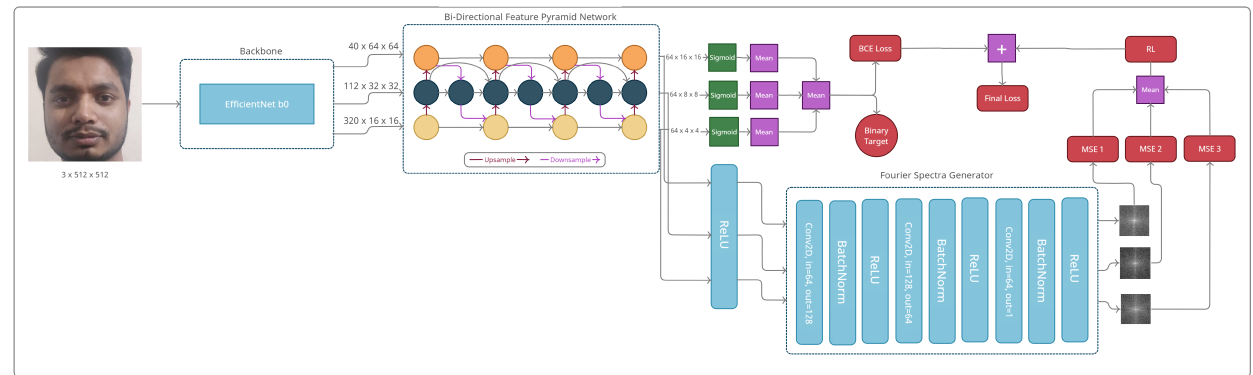
Figure 6. Extension of our baseline BiFPN architecture with a convolutional generator and reconstruction loss terms for the BiFPN-based spoof detection model